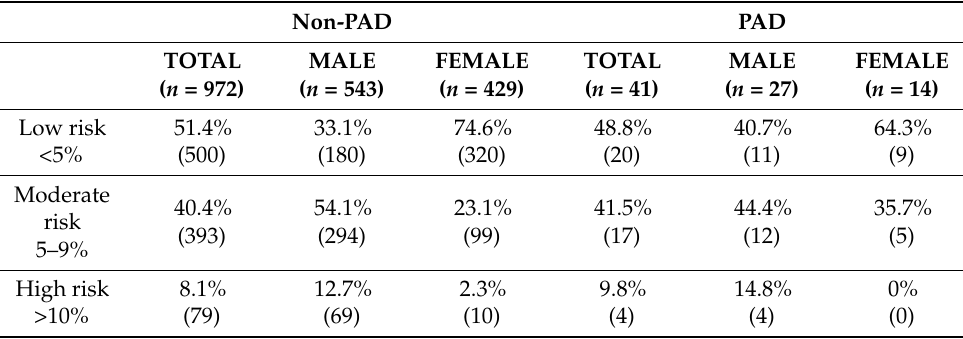
Table 3. REGICOR results in general population separated by sex and PAD.